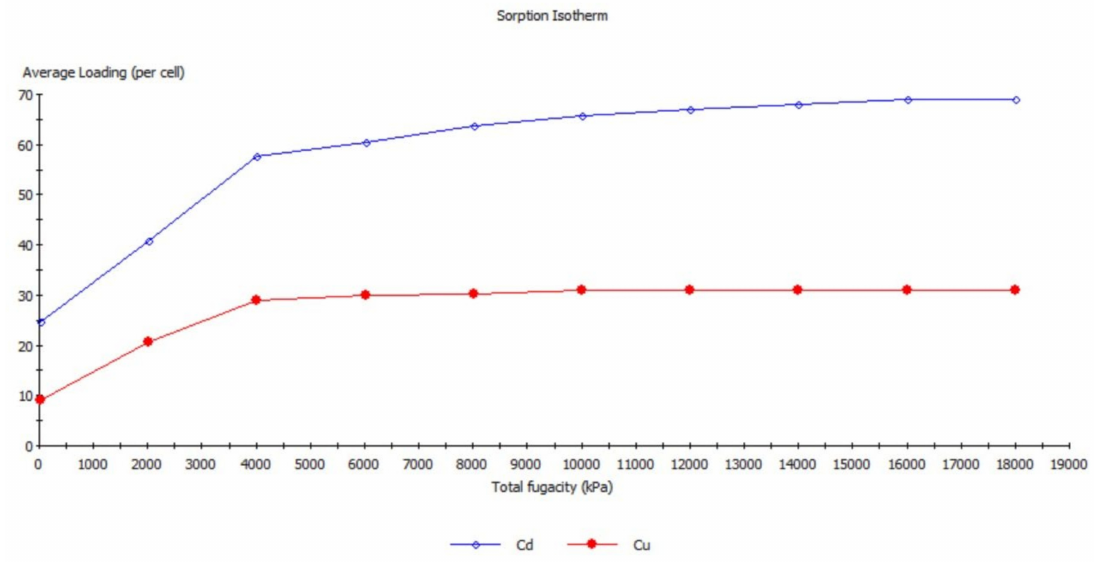
Figure 13. Theoretical equilibrium isotherms for Cu 2+ and Cd 2+ .